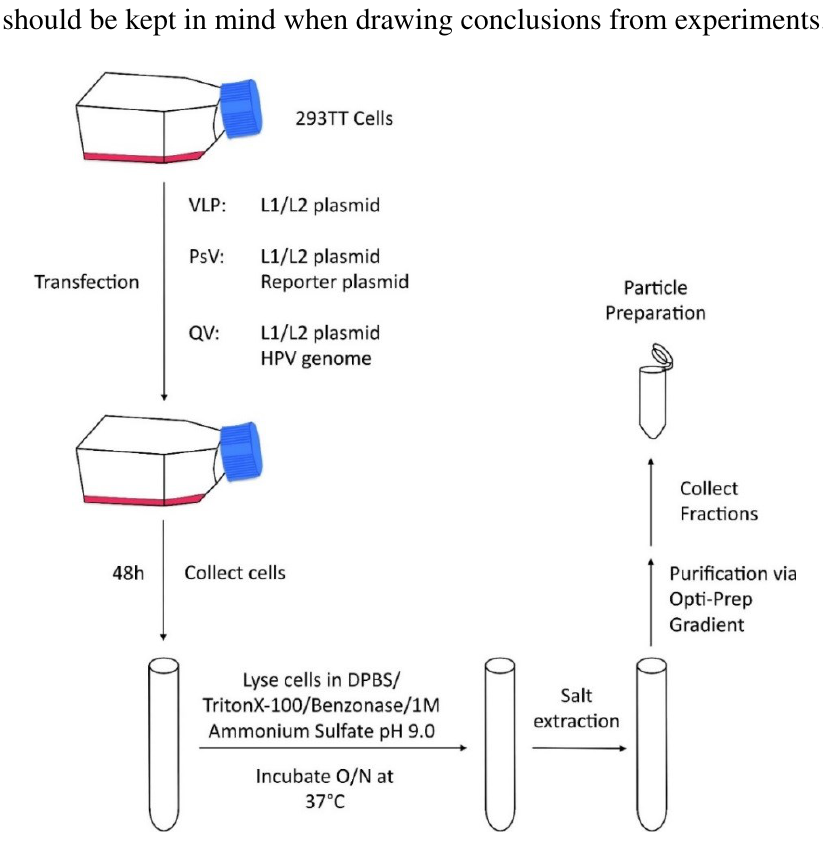
Figure 2. Schematic of recombinant HPV particle production. 293TT cells are transfected with a L1/L2 plasmid (VLPs), a L1/L2 plasmid and a reporter plasmid (PsVs), or a L1/L2 plasmid and a full HPV genome (QVs). Forty-eight hours post transfection, cells are harvested, lysed, and incubated at 37 °C overnight in the presence of cell lysate. Particles are then purified on a gradient.